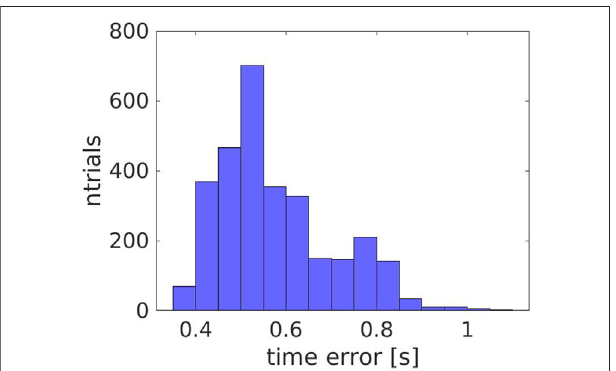
FIGURE 4 | Experiment 1: the measured (red) and the ground truth time (blue) with respect to the Actor ’ s speed.